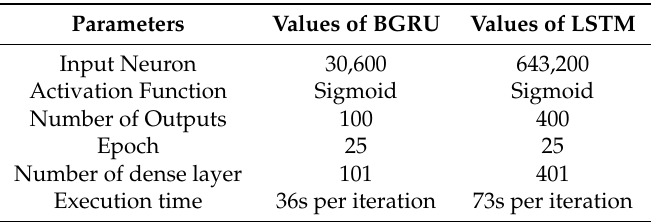
Figure 8. Working of bidirectional Gated Recurrent Unit (GRU). Table 3. Parameters of Bidirectional Gated Recurrent Unit (BGRU).